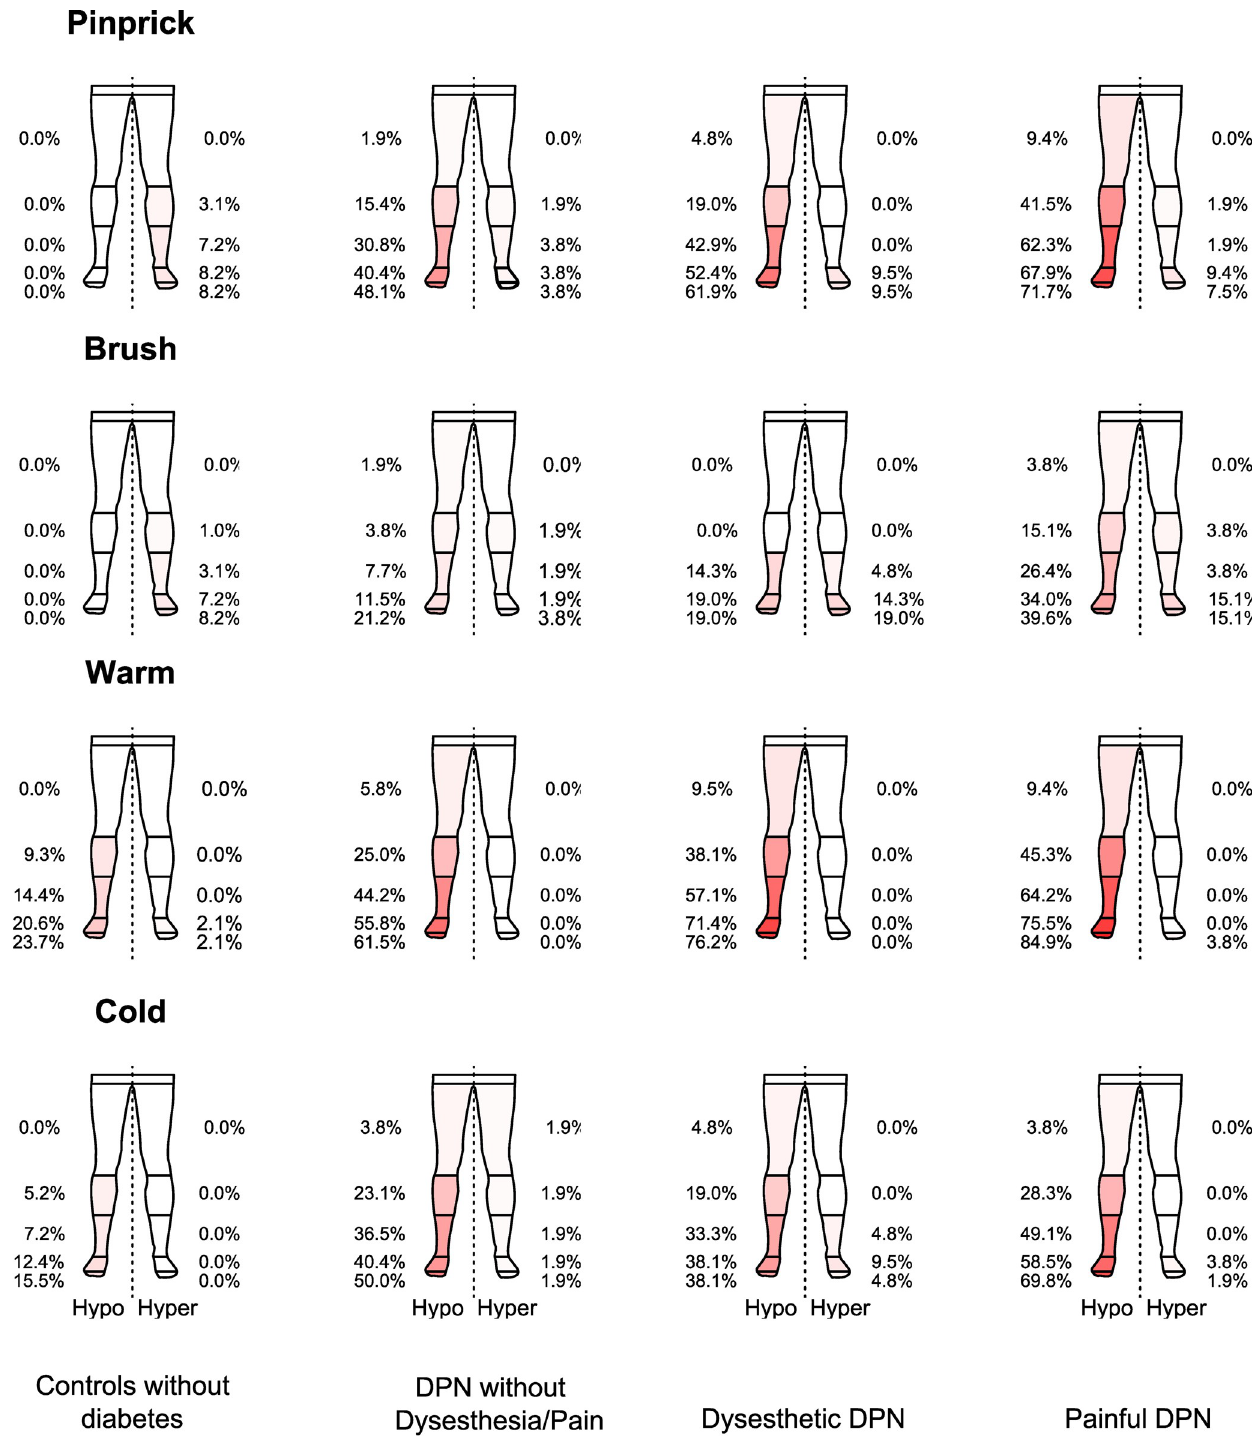
Fig 3. Sensory mapping of lower extremities in controls without diabetes, patients with DPN without dysesthesia/pain, patients with dysesthetic DPN and patients with painful DPN. The correlation between the sum of areas with sensory loss and going from no dysesthesia/pain to dysesthetic DPN and painful DPN. For pinprick: Hypoesthesia: r s = 0.35, P = < 0.001, Hyperesthesia: r s = 0.13, P = 0.16, brush: Hypoesthesia: r s = 0.25, P = 0.004, Hyperesthesia: r s = 0.16, P = 0.08, warm: Hypoesthesia: r s s = 0.25, P = 0.004, Hyperesthesia: r s = 0.14, P = 0.12 and cold: Hypoesthesia: r s = 0.17, P = 0.06, Hyperesthesia: r s = 0.14, P = 0.12. Sensory loss or gain is displayed in percentages from the toes to thighs with hypoesthesia to the left and hyperesthesia to the right. We calculated averages (sum scores) for the right and the left side. There was no difference between sum scores on the left and right leg.